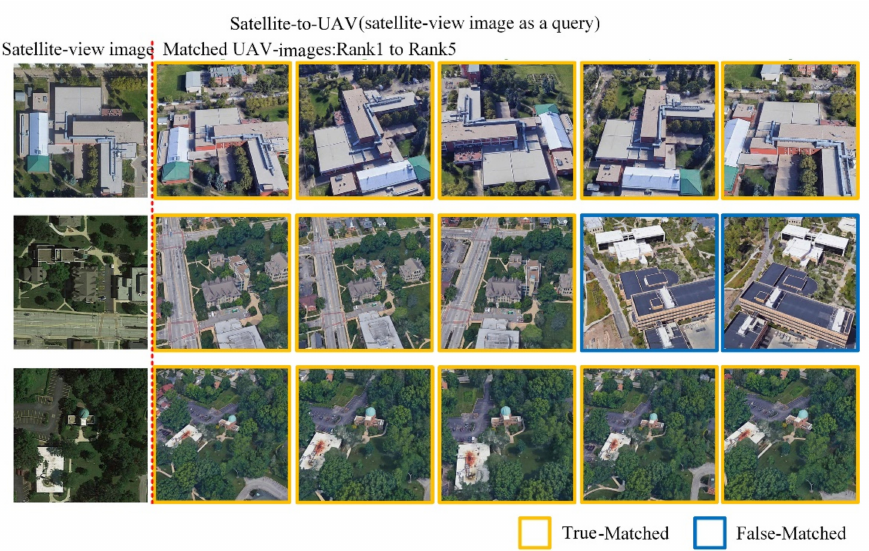
Figure 6. The top five images in the ranking of the matching result for satellite-to-UAV when a single satellite-view image is used as the